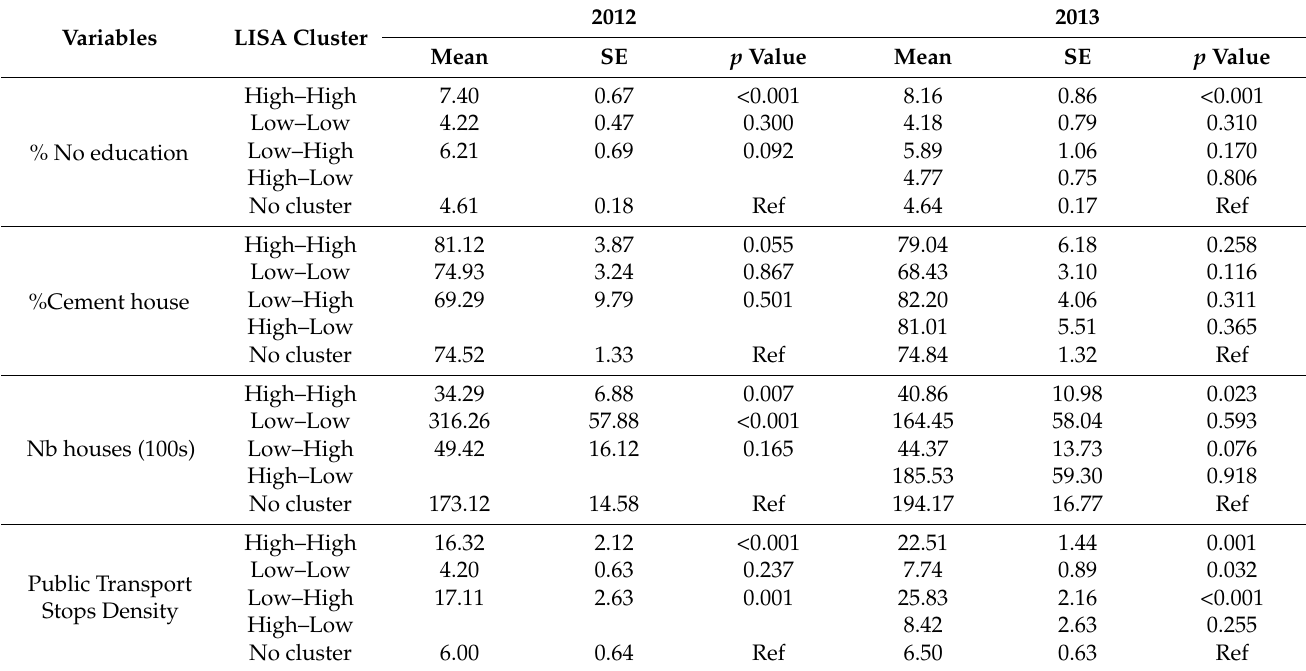
Table 4. Association of globally significant socio-economic variables with hotspot/cold spot clusters identified by